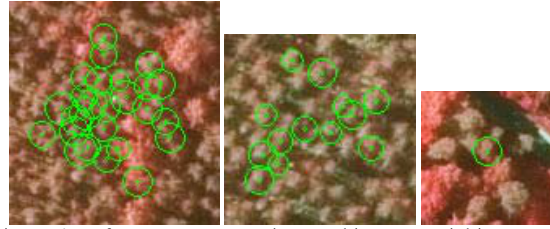
Figure 6. Reference trees superimposed into an aerial